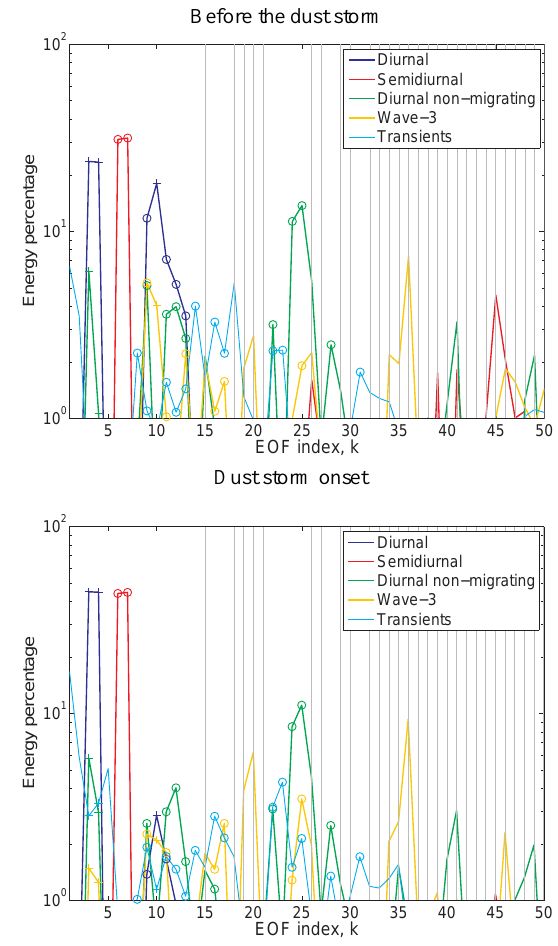
Fig. 5. Energy percentage represented by each EOF for various at- mospheric waves (a) before ( L s < 182 ◦ ) and (b) during the onset of the planet-encircling dust storm (182 ◦ <L s < 190 ◦ ). Low-order modes and transitional-modes are marked with cross and circle, re- spectively. Grey vertical lines represent high-order